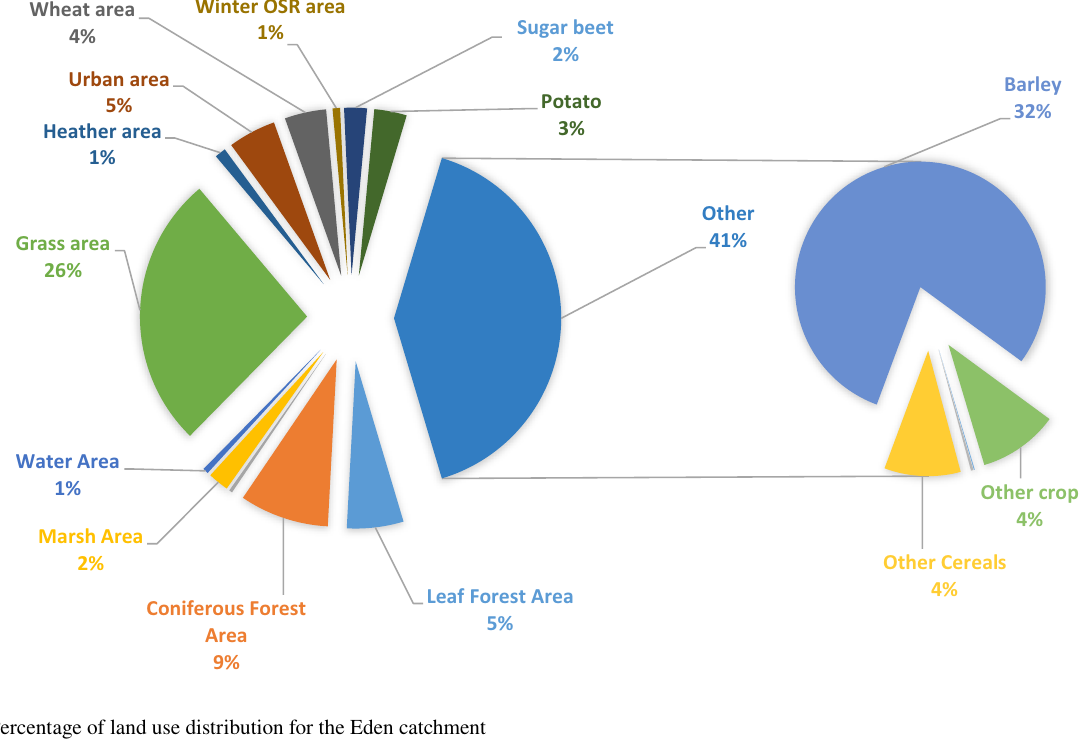
Fig. 6 Percentage of land use distribution for the Eden catchment